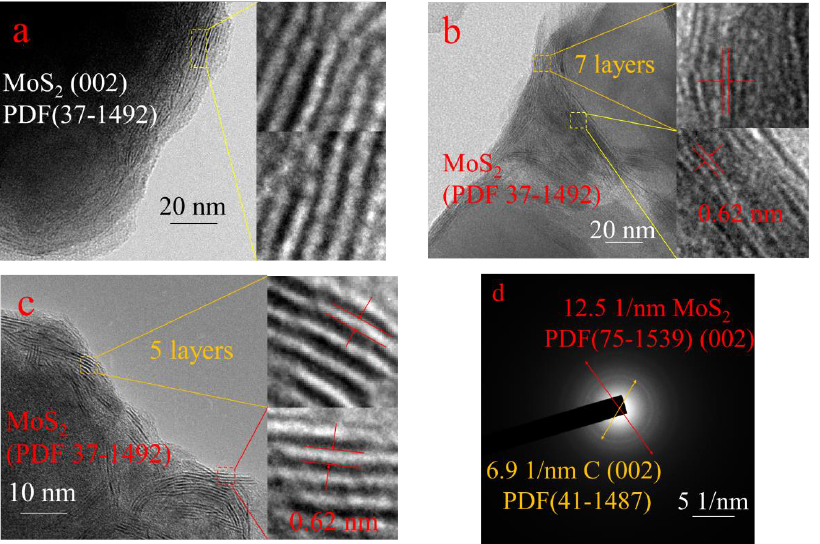
Figure 2. Catalyst characterization: ( a ) MoS 2 TEM (20 nm); ( b ) MoS 2 /C TEM (20 nm); ( c ) MoS 2 -45@C HRTEM (10 nm); ( d ) MoS 2 -45@C SAED (5 l/nm). HRTEM (10 nm); ( d ) MoS 2 -45@C SAED (5